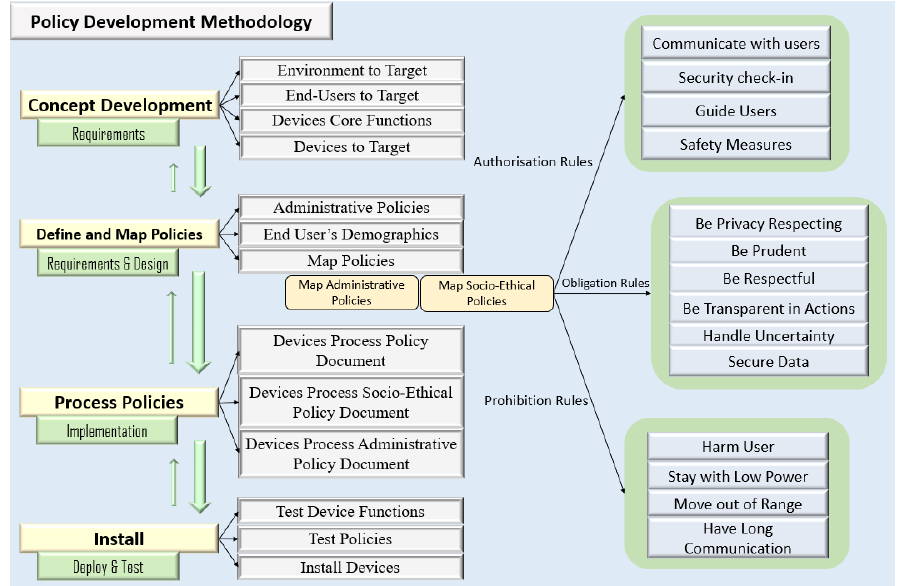
Figure 2. Policy development methodology for IoT